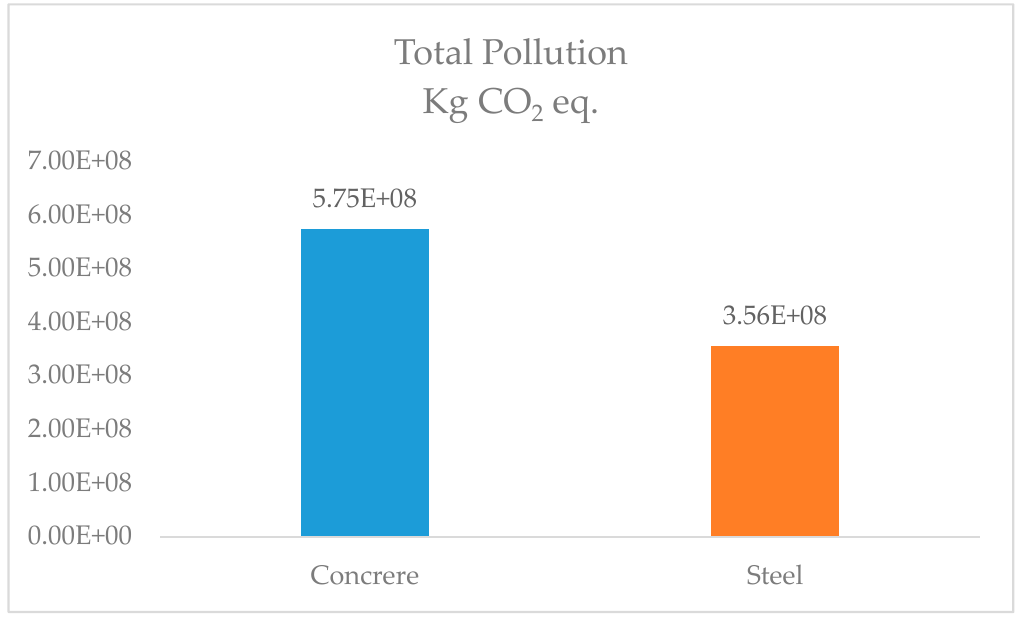
Figure 7. Total pollution released by two construction frames.